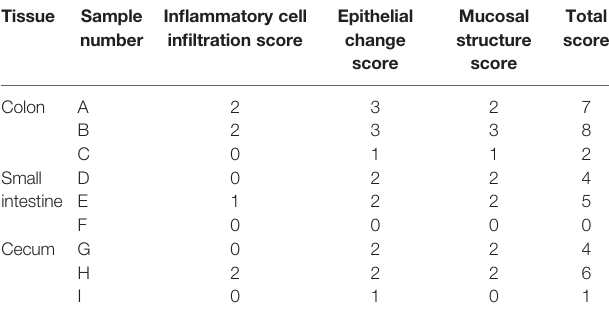
TABLE 1 | Histomorphological scores of intestinal in fl ammation in mice.